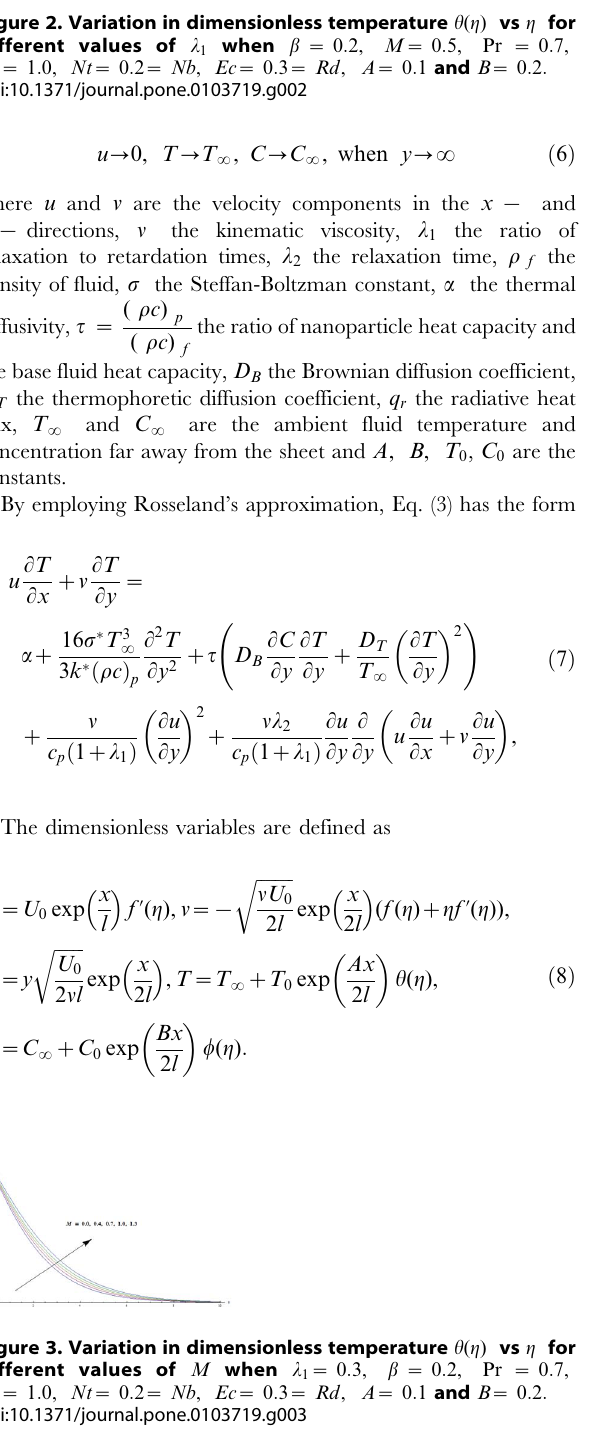
Figure 4. Variation in dimensionless temperature h ( g ) vs g for different values of Pr when l 1 ~ 0 : 3, b ~ 0 : 2, M ~ 0 : 5,